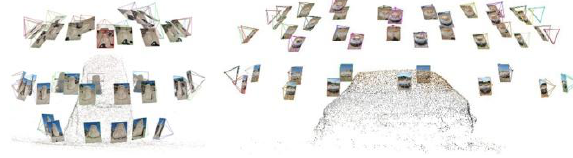
Figure 11: Alignment of closed blocks with open source software